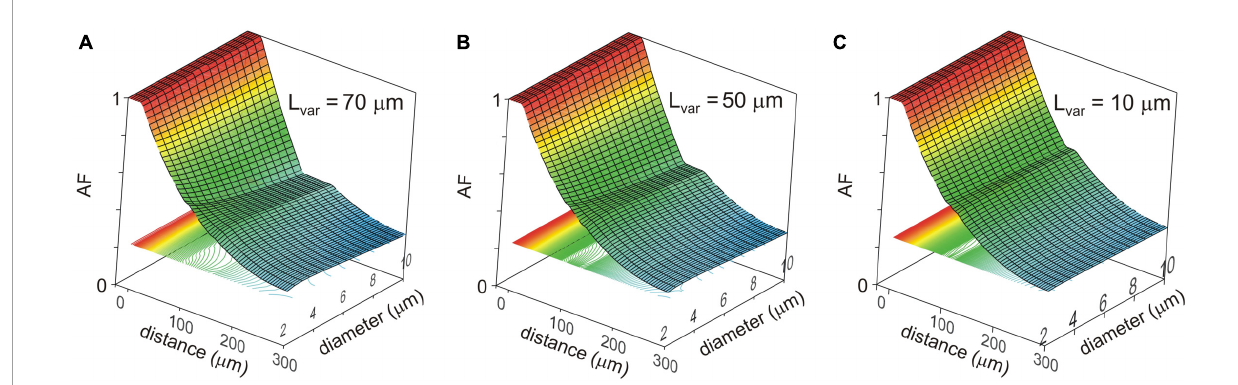
FIGURE3 Surface and contour plots of the color-coded attenuation factor (AF) (applicate, dimensionless) in function of the path distance from soma x (abscissa, µ m) and varicosity diameter D var (ordinate, µ m) for different varicose section lengths L var = 70, 50, and 10 µ m (A–C) . The AF range is subdivided into approximately 100 levels represented by the correspondingly colored contour plots in XY plane.